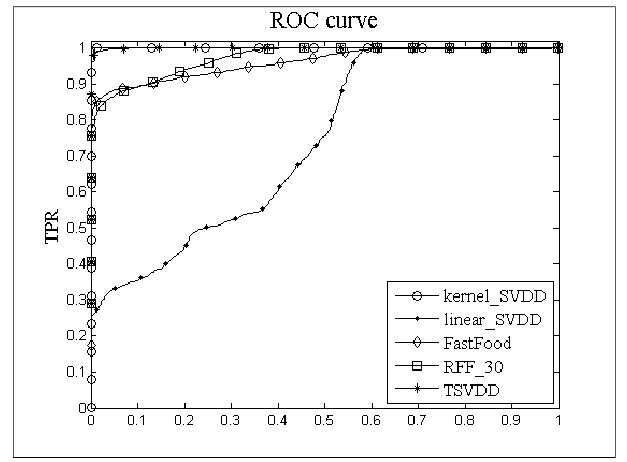
Figure 7. ROC curve.